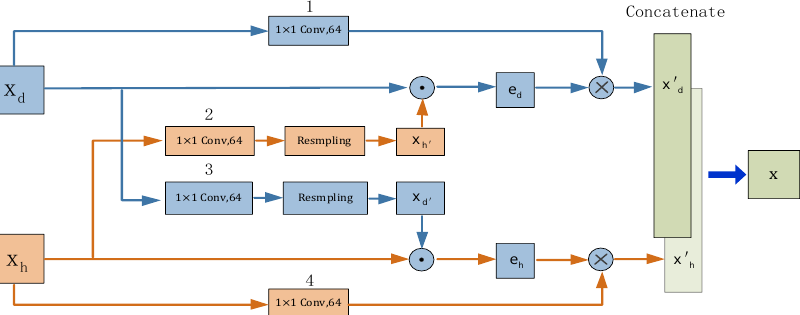
Figure 6. r-ResNet. The input of rResNet is the Mel energy spectrogram. Sequentially, this paper decomposes the frequency into high-frequency part k h and low-frequency part k l , respectively. The classical ResNet is modified by only adding a skip connection branch of high-frequency part k h . This study justifies this because convolution is a low pass filter, if high-frequency part passes the low pass filter that will lose a lot of detail information.